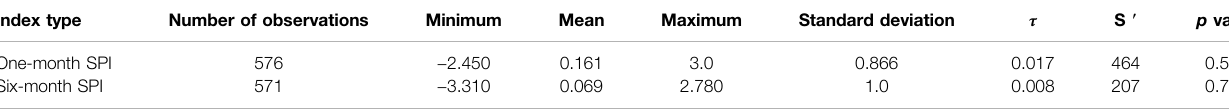
TABLE 3 | Results of evaluating time series with the seasonal Mann – Kendall test.